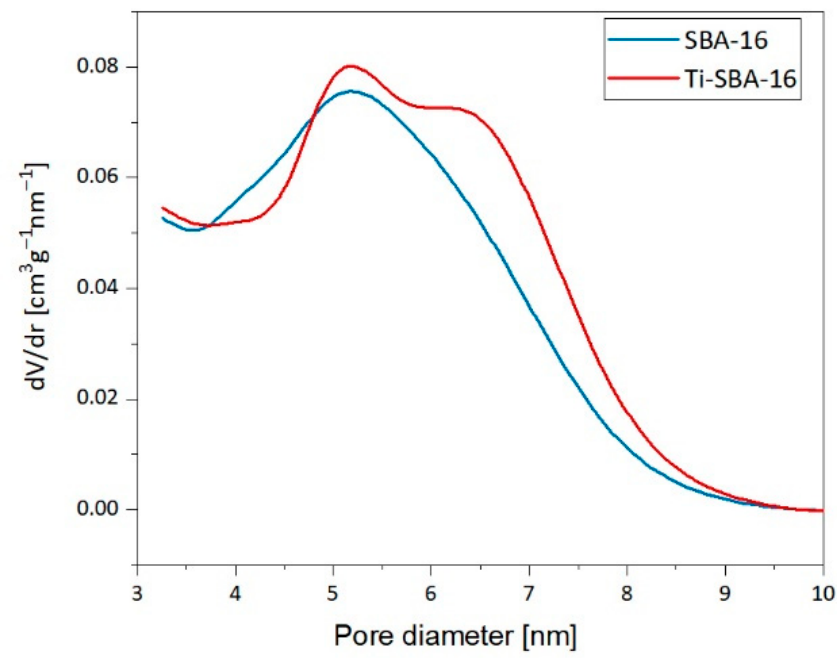
Figure 4. Cage diameter distribution calculated by the Barrett–Joyner–Halenda (BJH) method from the adsorption branch for the SBA-16 and Ti-SBA-16.